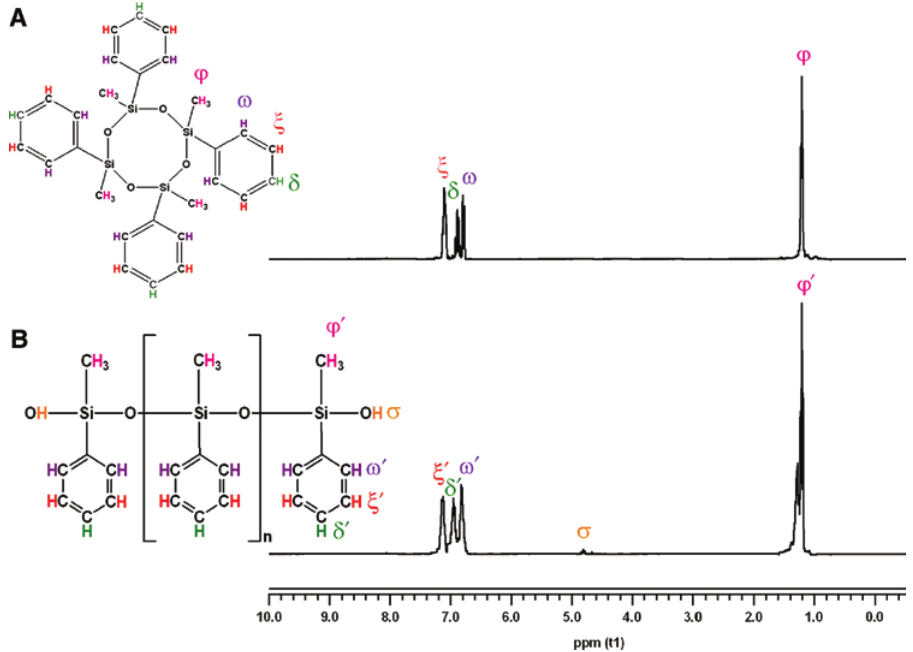
Figure 3: 1 H nuclear magnetic resonance (NMR) spectra of (A) tetraphenyltetramethylcyclotetrasiloxane (D 4Ph,Me ) and (B) polymer obtained at a temperature of 60 ° C for 150 min.